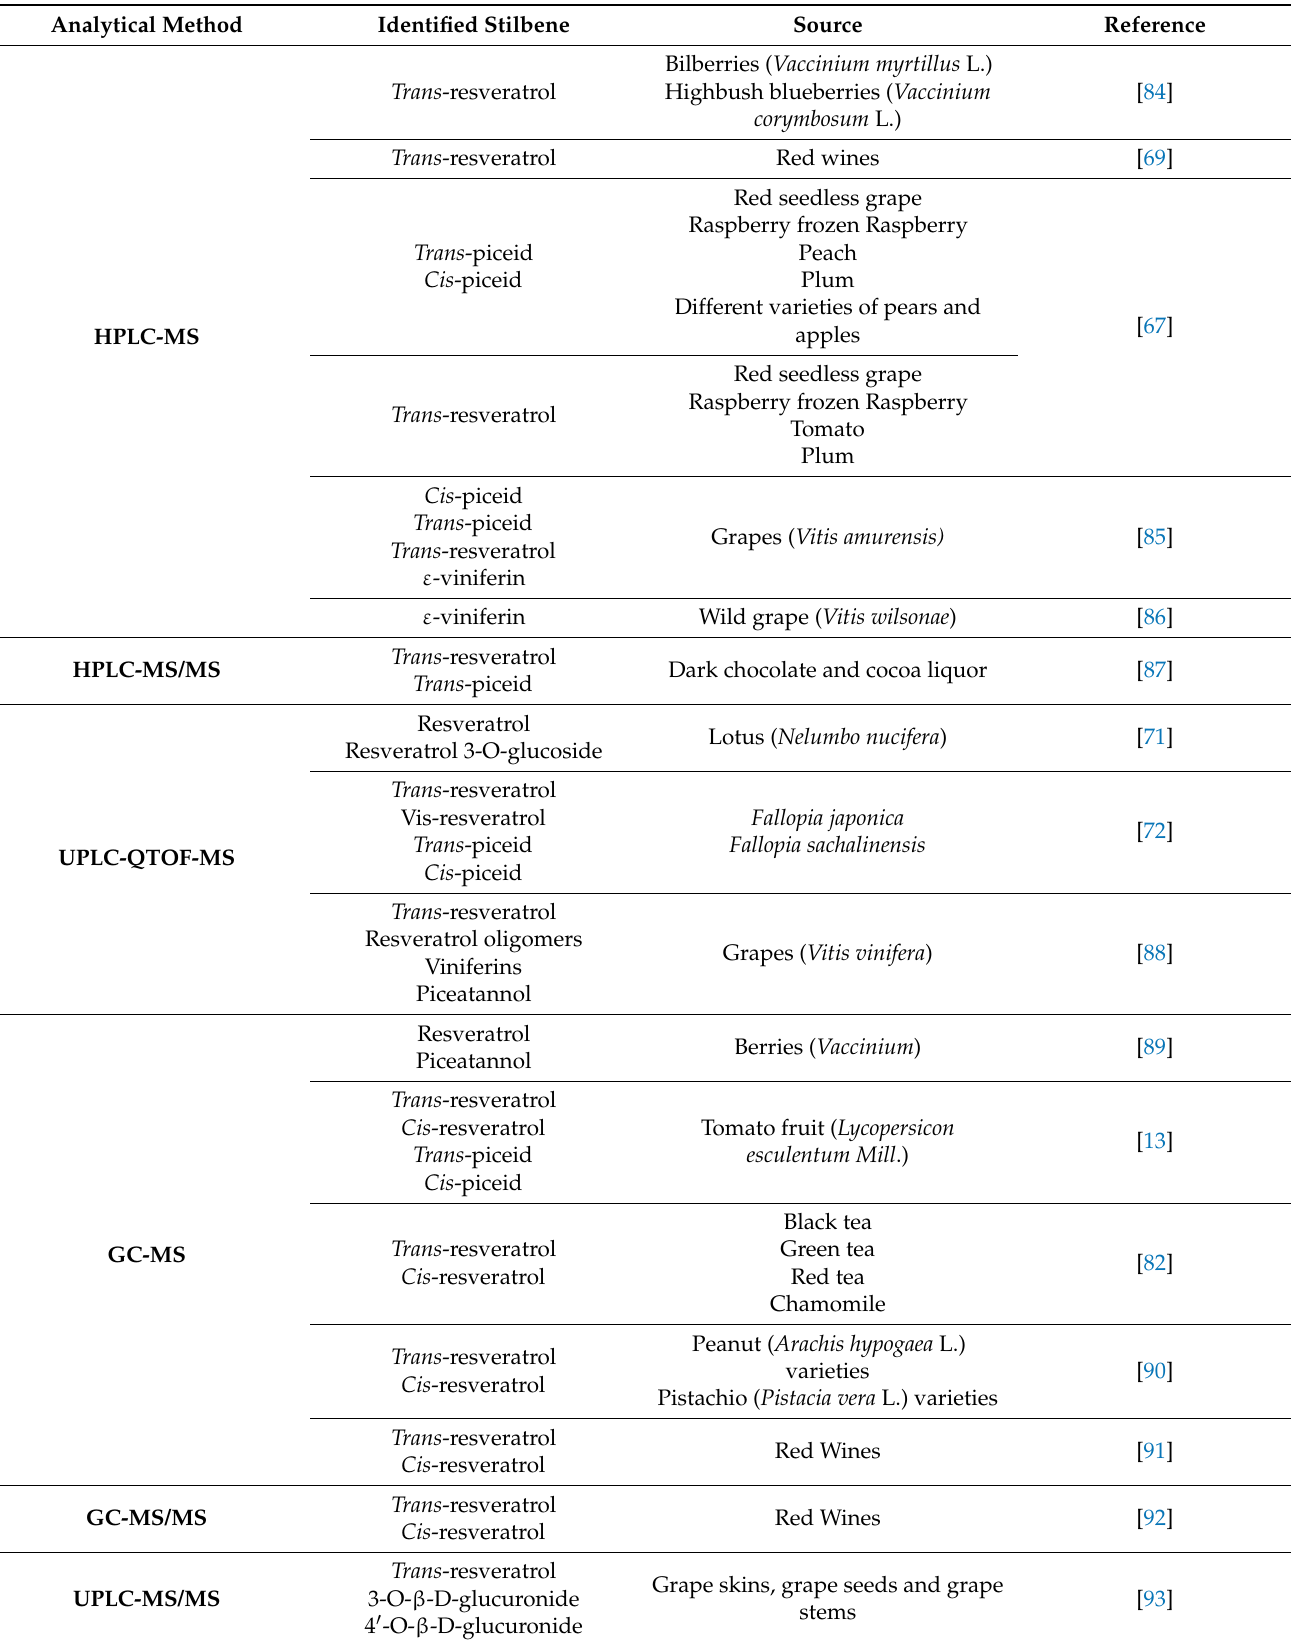
Table 1. Methods for identifying stilbenes from natural sources used successfully in various